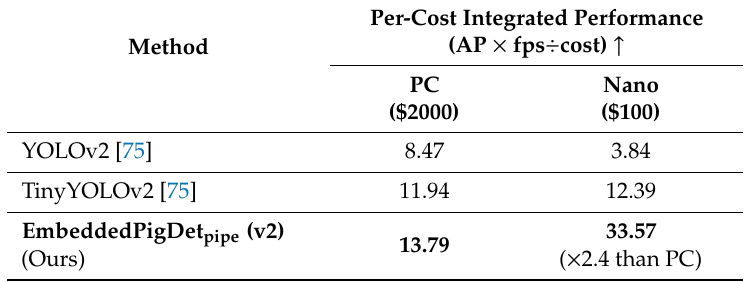
Table 7. Comparison of per-cost integrated performance on PC and Nano board